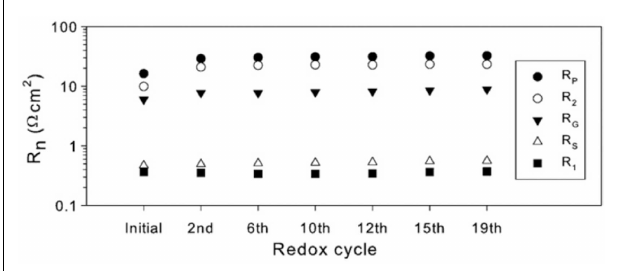
FIGURE 8 | Fitted parameters of the composite electrode (Sr 0.94 Ti 0.9 Nb 0.1 O 3 –YSZ) symmetrical cell as a function of redox cycles at 850°C . Each point was measured ca 13h after re-reduction. R s is the resistance determined from the high frequency offset.The polarization resistance ( R P ) is the sum of R 1 , R 2 , and R G from equivalent circuit fitting [ LR S ( Q 1 R 1 ) G ( Q 2 R 2 )] (Blennow et al., 2009). Reprinted with permission from